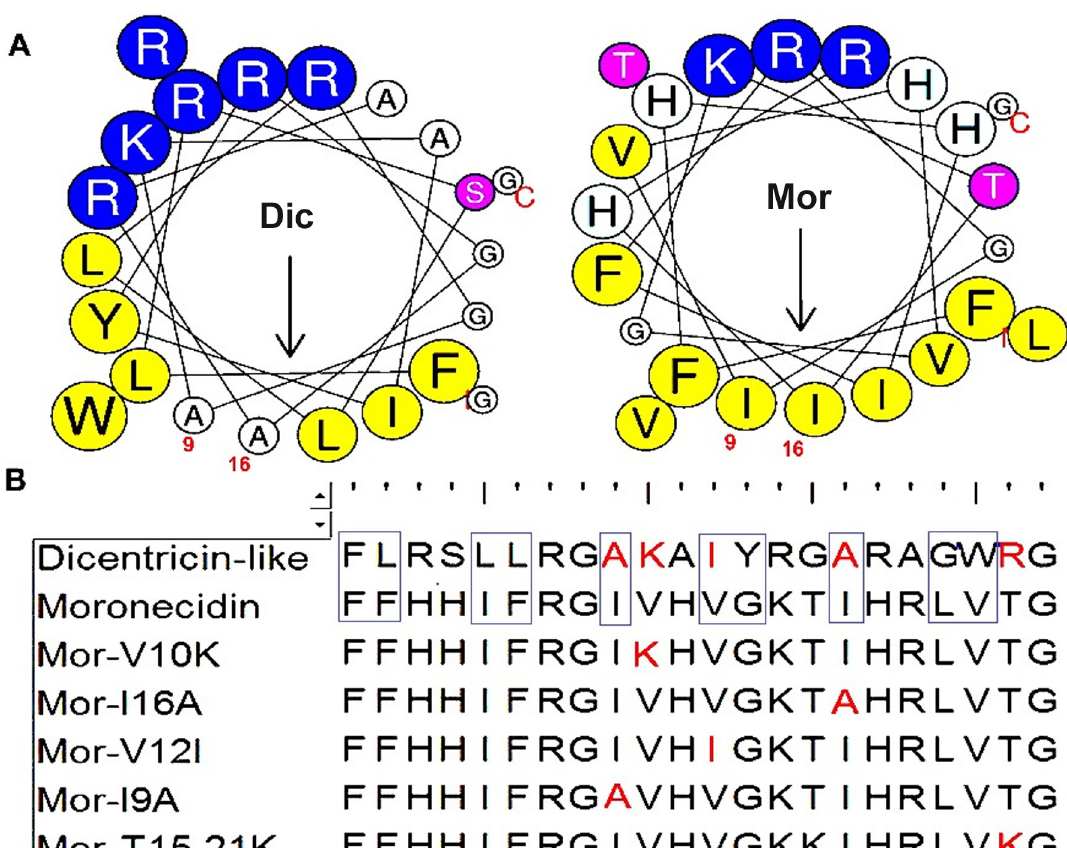
Fig 9. Helical wheel projections for dicentracin-like and moronecidin. Residues are numbered starting from the N-terminus. B : The alignment of dicentracin-like with moronecidin and its derivatives [57–59].Red residues represent identical residues between dicentracin-like (Dic) and moronecidin (Mor) derivatives. Hydrophobic face residues in dicentracin-like and moronecidin are shown by rectangular.